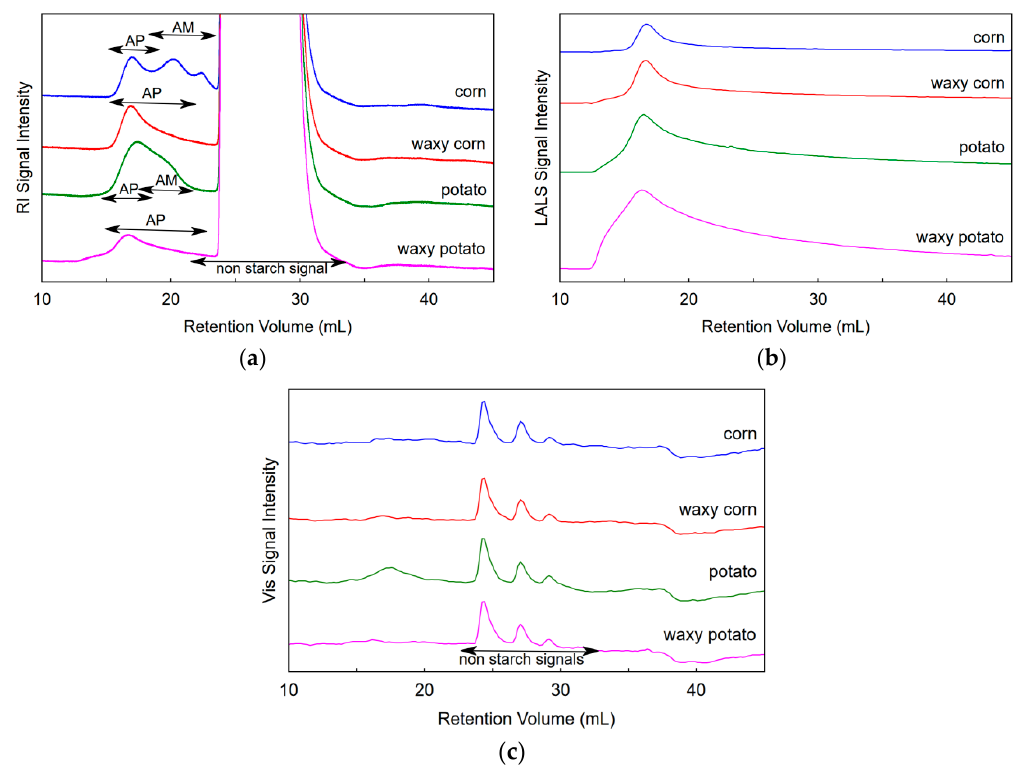
Figure 3. SEC chromatograms of corn, waxy corn, potato, waxy potato starch; ( a ) signals of the refractive index (RI) detector, ( b ) four-capillary viscometer (Vis) detector, ( c ) low-angle light scattering (LALS); the samples were dispersed in aqueous solution of urea/NaOH at 0 °C for 24 h and eluted with 50 mM phosphate buffer (pH 8.0) with 100 mM urea. The arrows indicate amylose (AM) and amylopectin (AP) ranges; the possible traces of amylose in waxy starches were neglected.